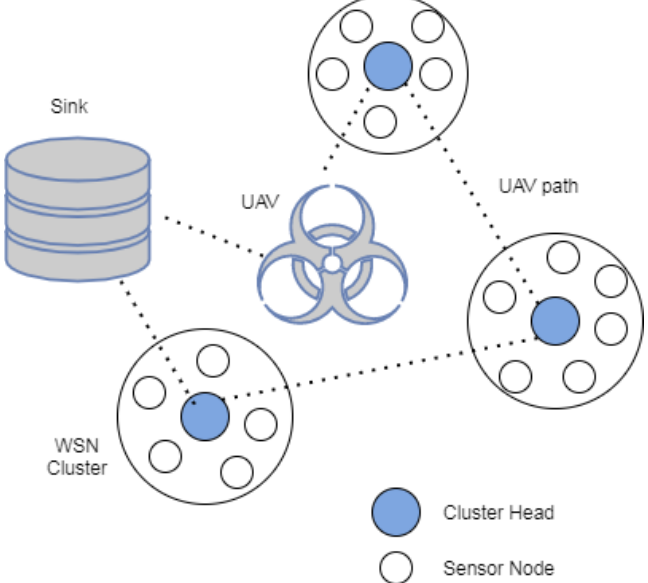
Figure 4. Drone path in a WSN cluster.